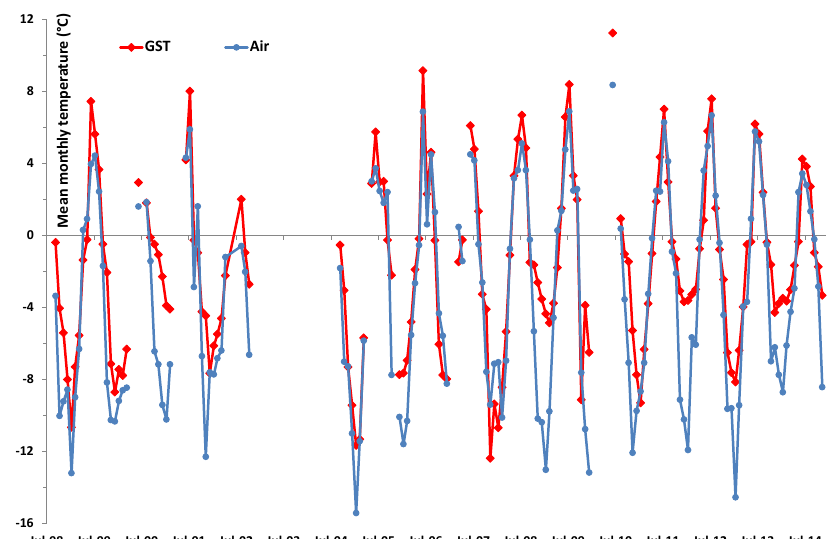
Figure 11. Trend of monthly mean of GST (red line) and air temperature (blue line) at SSB since 1998.